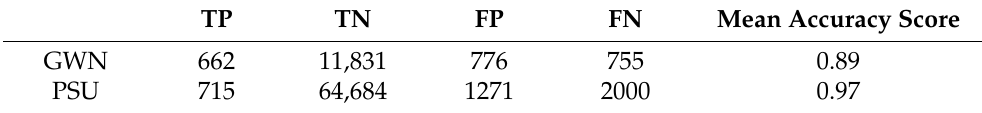
Table 5. Confusion matrix scores obtained with ML CSD models in testing dataset at GWN and